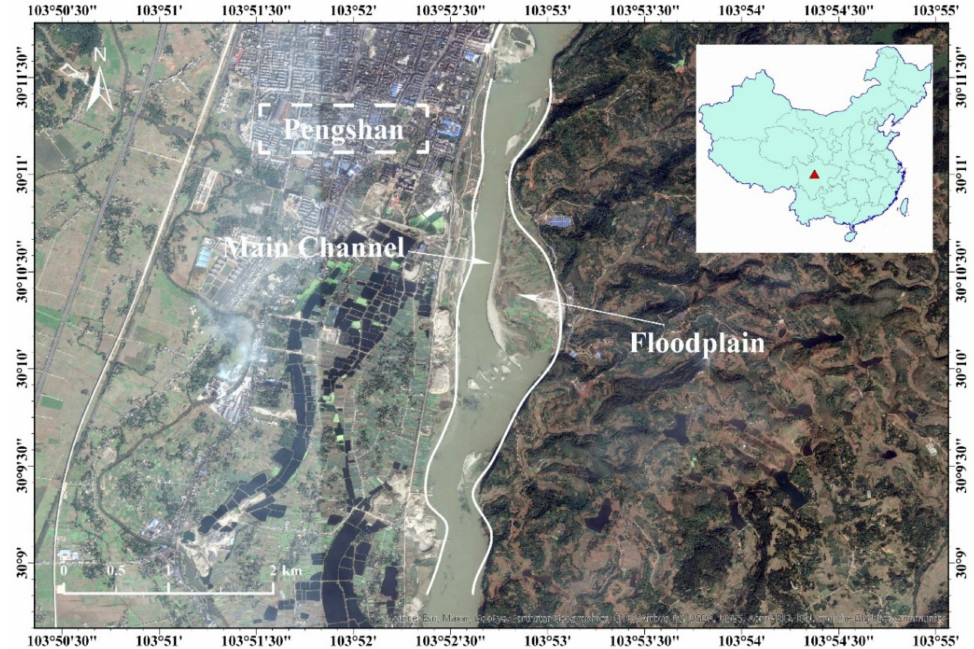
Figure 1. Abruptly widening compound channel between two single channels in the Pengshan reach of Min River (flow direction is from the North to